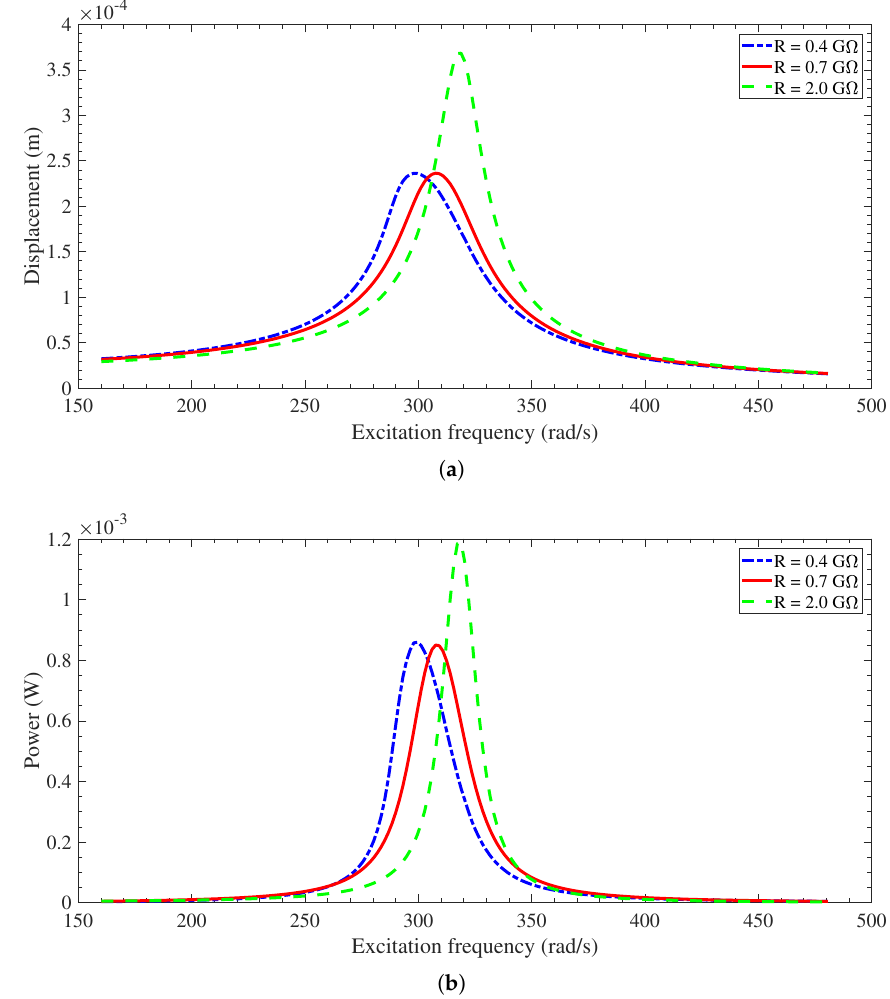
Figure 15. Frequency–response curves in terms of ( a ) displacement and ( b ) electrical harvested power for V et = 2400 V and F = 3 m/s 2